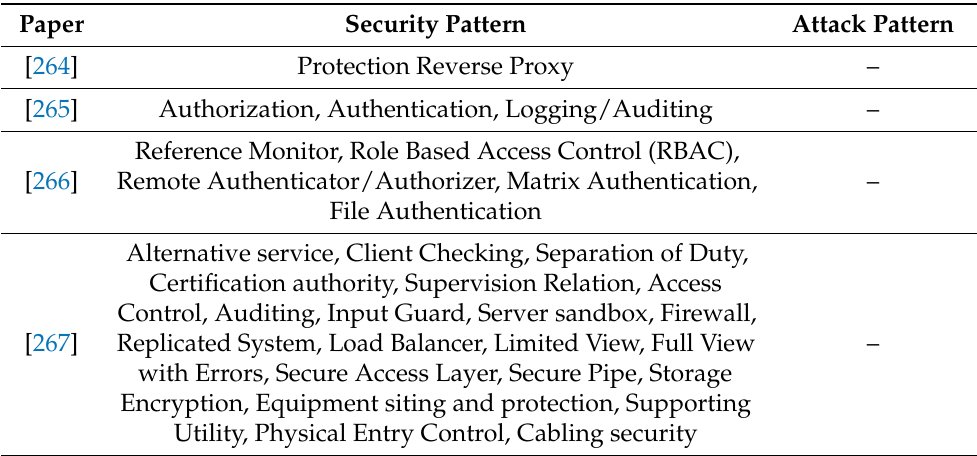
Table 7. Classification of latest papers: Pattern.